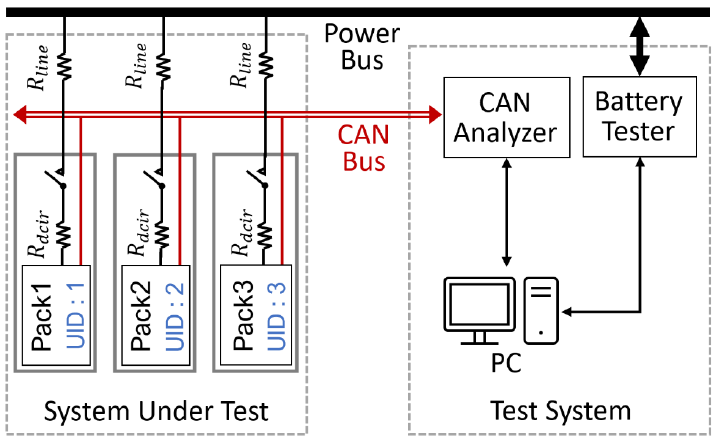
Figure 6. The schematic of charging and discharging experiment on the battery power network.